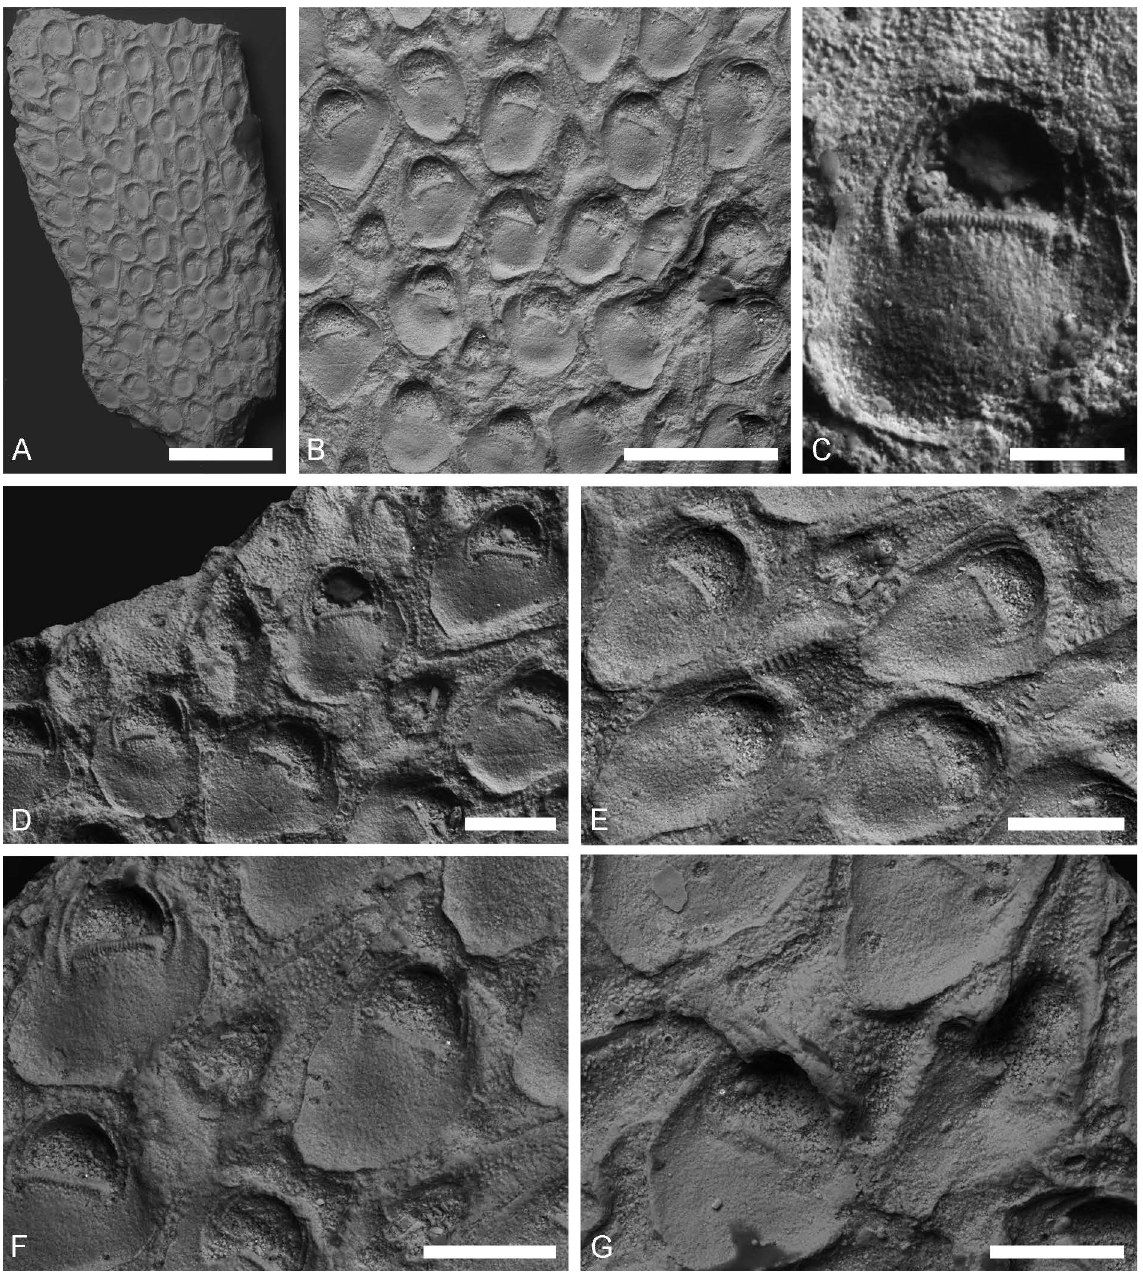
Fig. 10. Rhagasostoma aralense sp. nov., southern Aral Sea Region, Uzbekistan. A–F . Holotype, TsNIGR Museum 26/12582, early Campanian, Cibicidoides temirensis / Bolivinoides decoratus decoratus Zone. A . Overview of erect bifoliate colony. B . Autozooids with proximolateral peripheral caverns and avicularia. C . Opesia of non-ovicellate autozooid with crenulated proximal edge. D . Edge of the colony with autozooids, avicularia, and kenozooids. E . Non-ovicellate autozooids with proximal peripheral caverns and avicularium. F . Non-ovicellate autozooids and avicularia. G . Paratype, TsNIGR Museum 28/12582, middle Campanian, Brotzenella monterelensis Zone, ovicellate autozooid and avicularium. Scale bars: A = 1 mm; B = 500 µm; C = 100 µm; D–G = 200